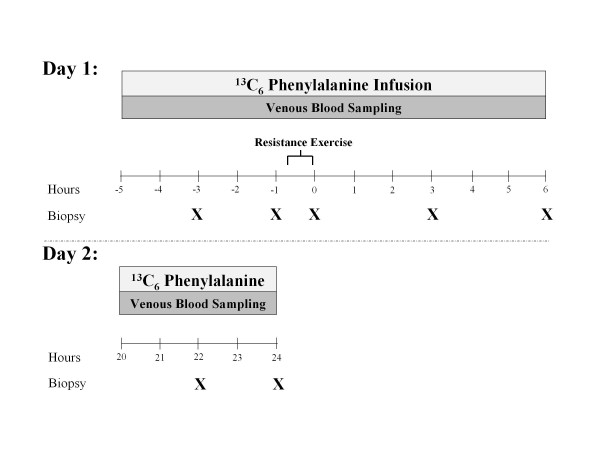
Study design. Blood was sampled throughout the study and muscle samples were taken at the times indicated (X). Exercise was performed after the second biopsy.